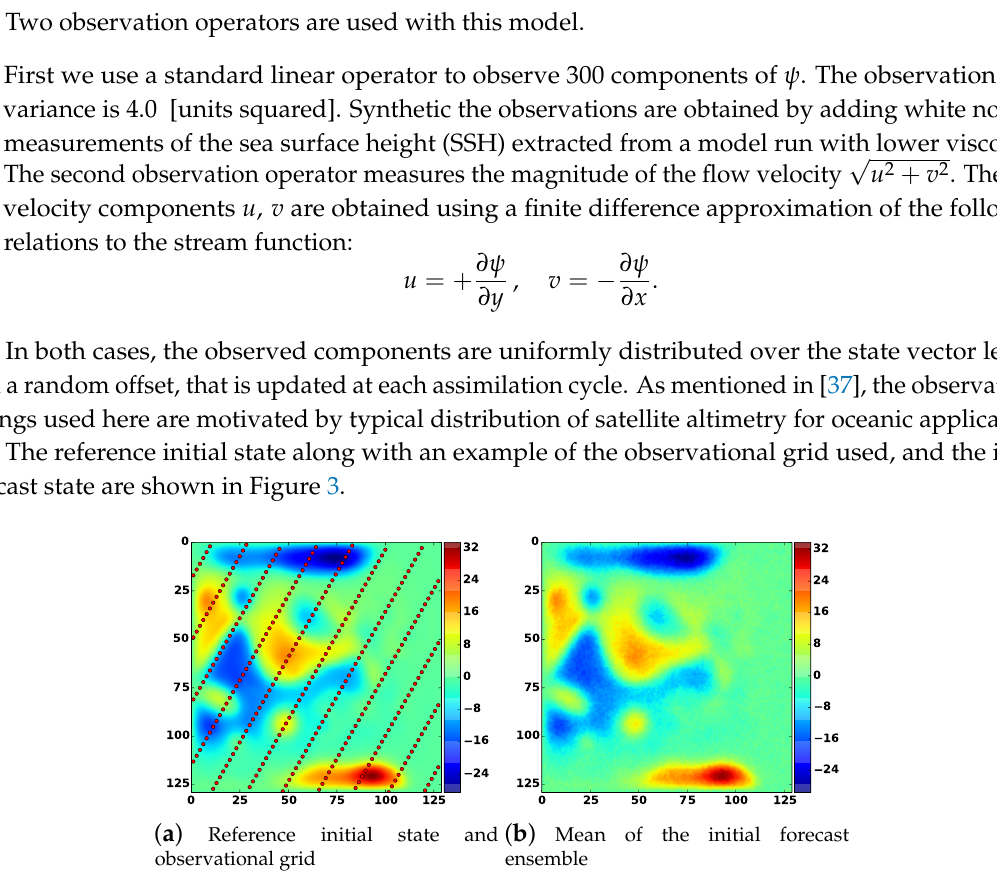
Figure 3. The QG-1.5 model. The red dots in ( a ) indicate the location of observations for one of the test cases